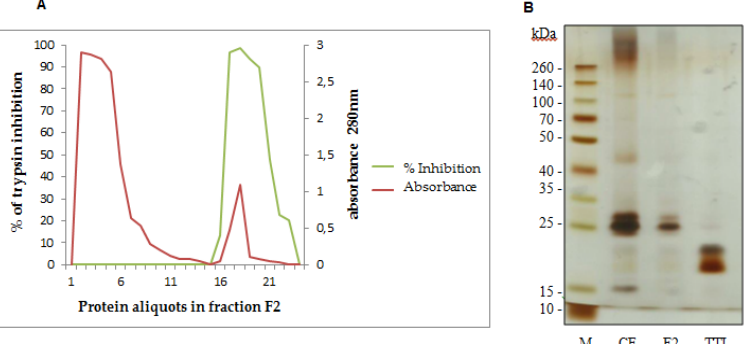
Figure 1. ( A ) Trypsin-sepharose affinity chromatography profile of fraction F2 obtained from Tamarindo seeds. The first peak (red line) represents proteins with low trypsin affinity, firstly eluted, with no trypsin inhibition activity (green line). The second peak (red line) represents TTI, with high trypsin affinity and trypsin inhibition activity (green line). The trypsin-sepharose affinity column was calibrated with 50 mM Tris-HCl, pH 7.5 buffer. Eluition was done using a 5 mM HCl solution, at a flow rate of 0.5 mL/min. The percent of trypsin inhibition of the eluted proteins was evaluated using a trypsin inhibition assay [35] with 50 µ L of protein aliquots. Protein aliquots (3.0 mL) were observed at 280 nm. ( B ) Proteins were studied with 12.5% SDS-Polyacrylamide Gel Electrophoresis stained with silver nitrate of Tamarindo seeds. M: Marker (São Paulo, Brazil) (Spectra Multicolor Broad Range Protein Ladder); CE: Crude Extract; F2: fraction F2 saturated with 30%–60% of ammonium sulfate; TTI: Tamarindo seed Trypsin Inhibitor.